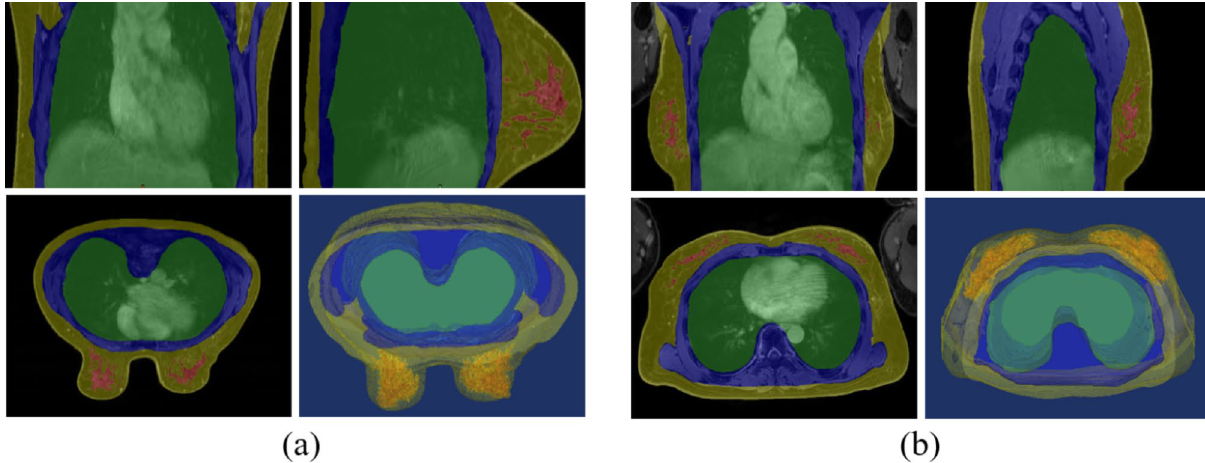
Figure 1. Typical multi-planner reformatted views. ( a ) prone MRI, and ( b ) supine MRI. (Left to right in the upper row: coronal and sagittal views; in the lower row, axial and 3D visualization views) (Colors: green: lungs and heart; blue, muscles and bones; red: parenchyma with cancer; yellow: skin and fat without parenchyma with